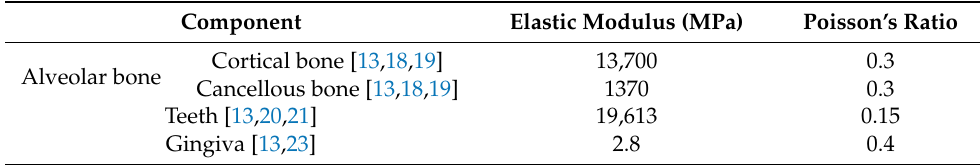
Table 1. Material properties of the components in the FE models—linear